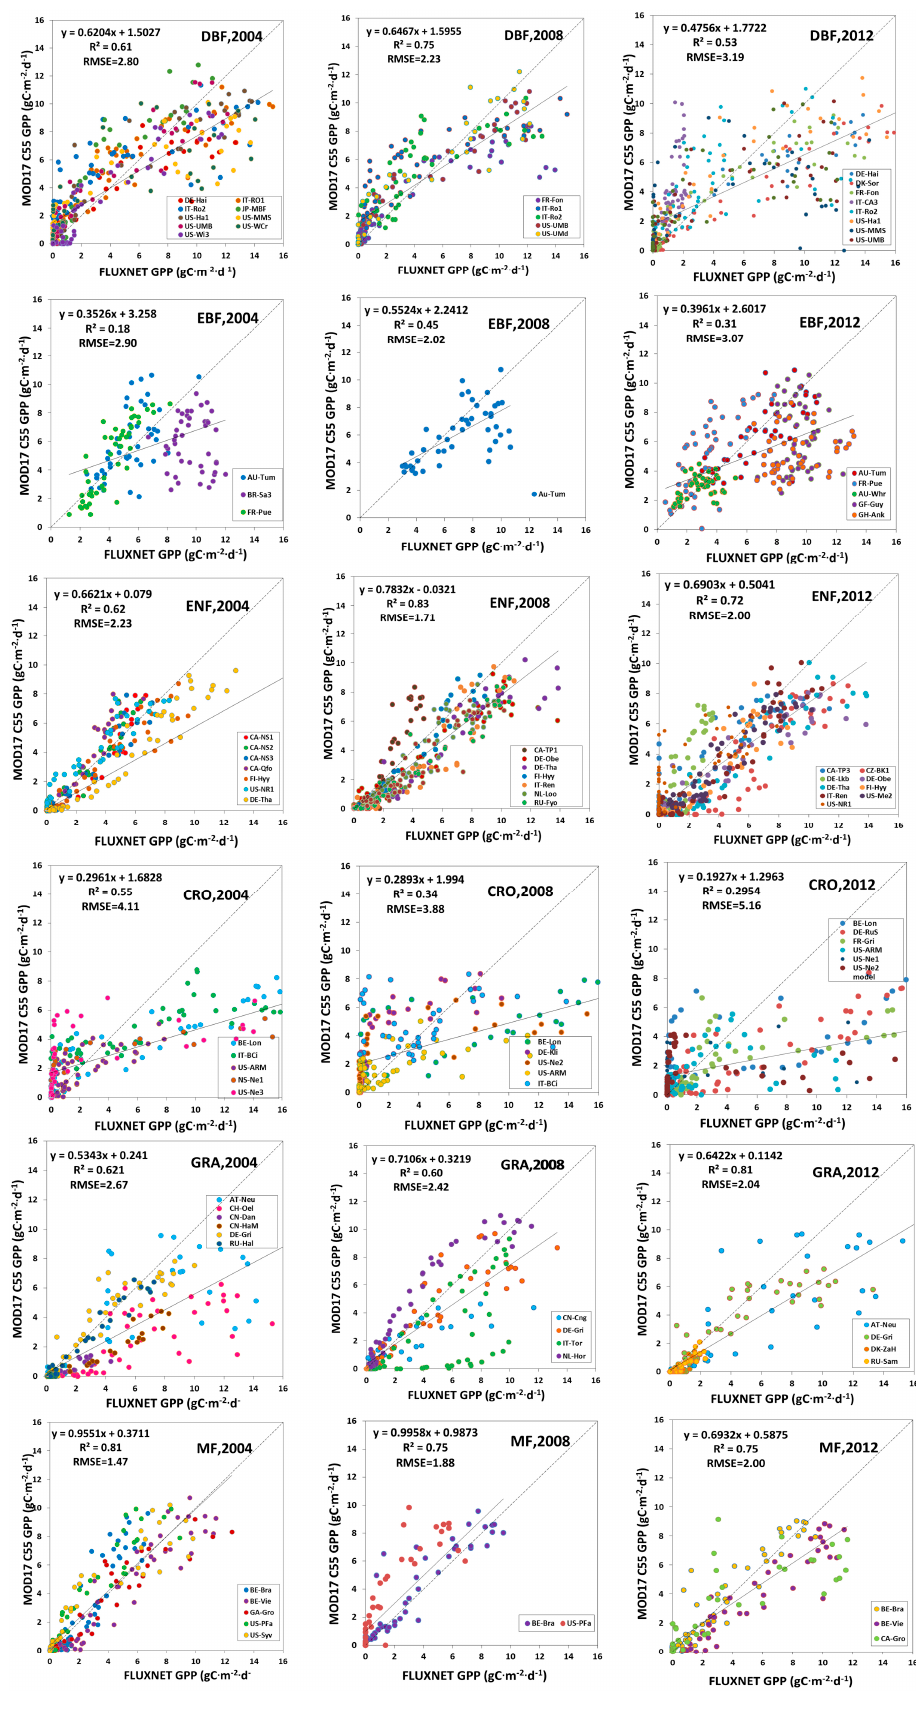
Figure 11. MODIS C55 GPP validation against FLUXNET GPP.